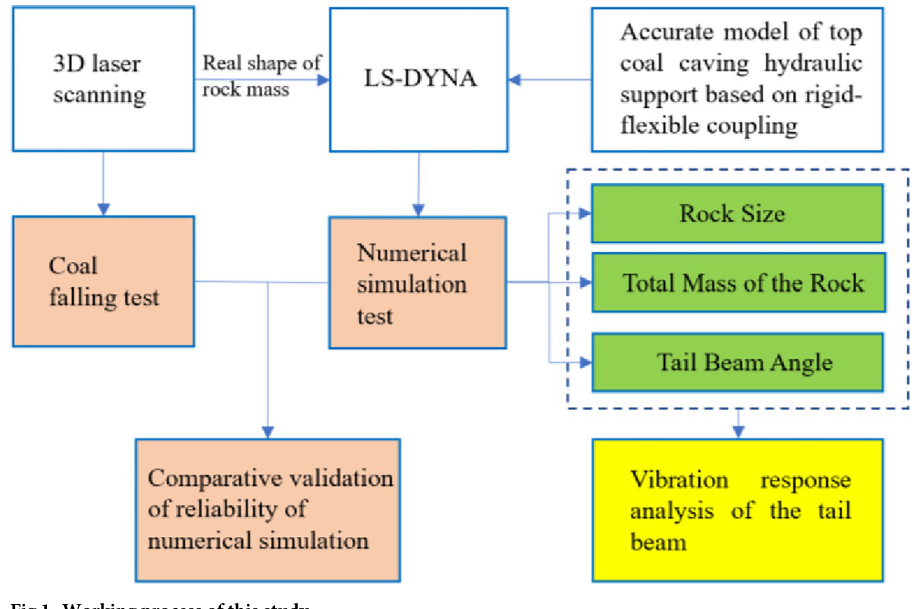
Fig 1. Working process of this